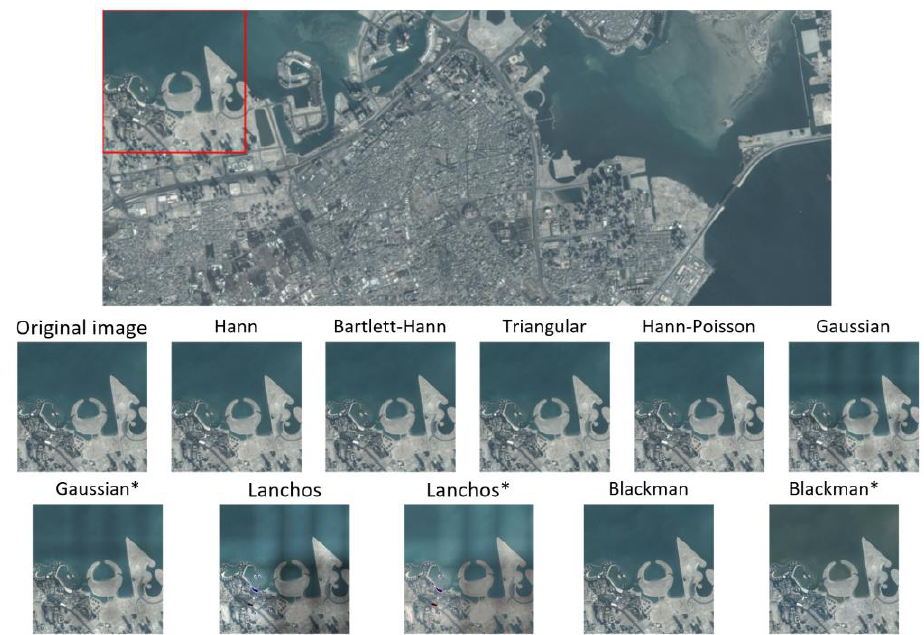
Figure 4. Sample image generated as a result of combining images with the use of selected windows. For methods marked with “*”, histogram adjustment was applied before combining images after adjusting the histogram to the reference image.